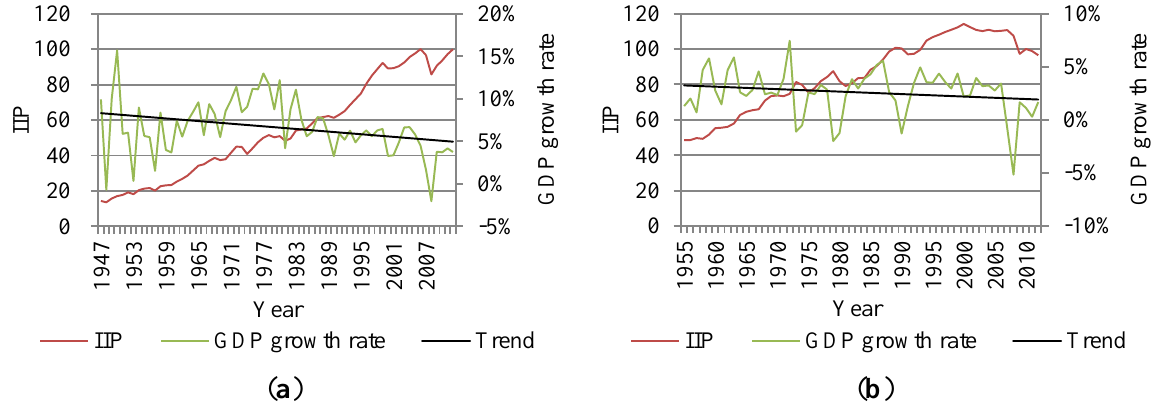
Figure 2. Annual growth rate of industrial production (IIP) and gross domestic product (GDP) in the U.S. and UK (Data source: [34–37]). ( a ) United States (Index 2007 = 100); ( b ) United Kingdom (Index 2010 = 100).